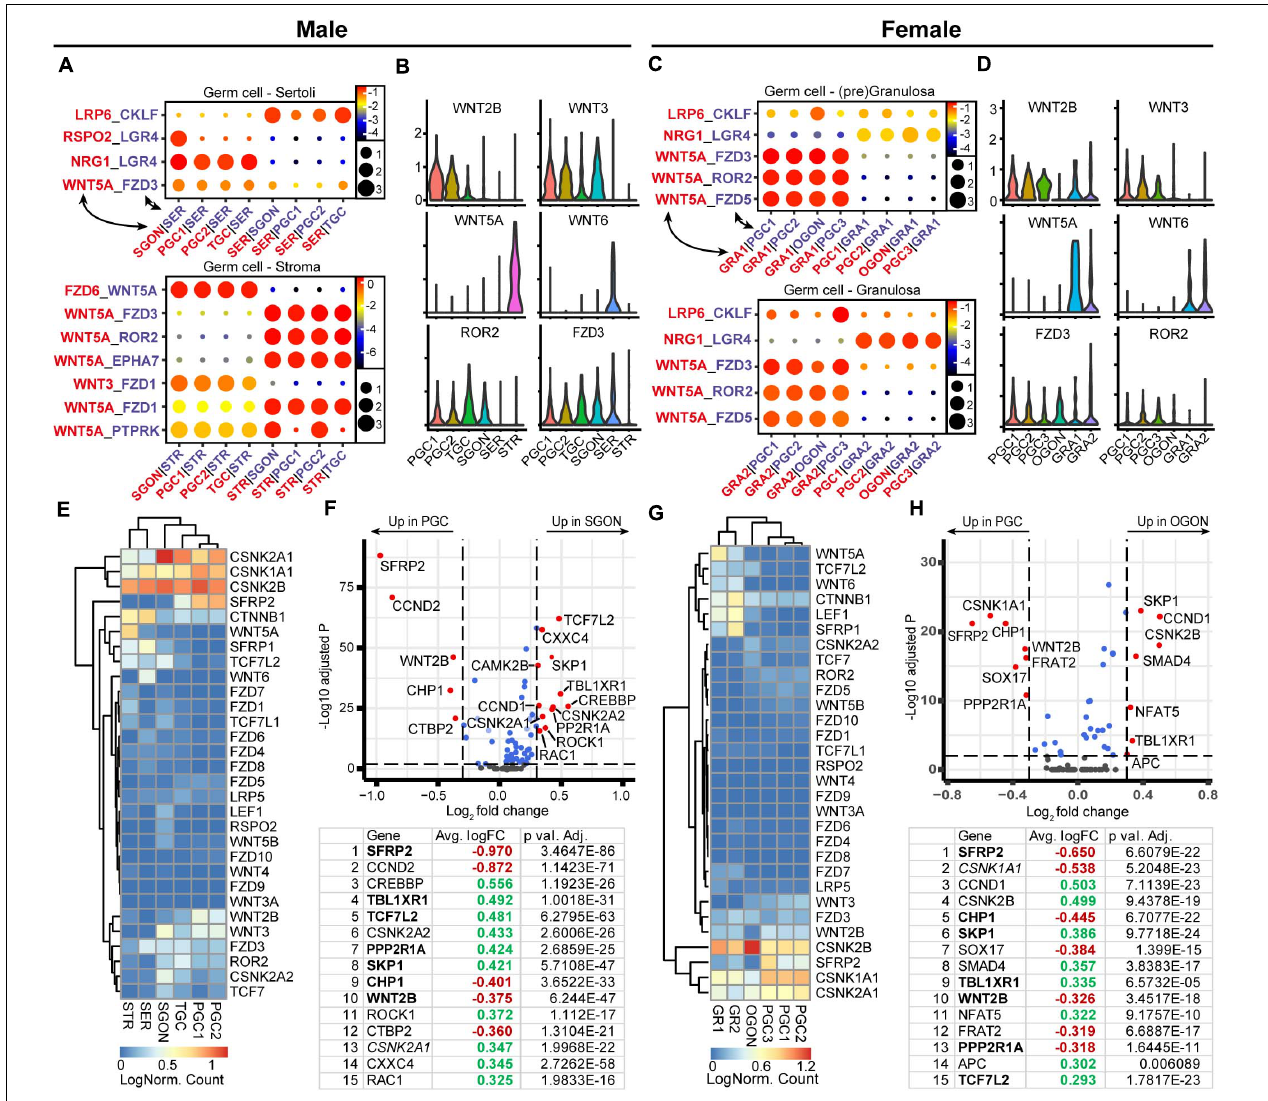
FIGURE 5 | Expression of WNT ligand–receptor pairs and downstream pathway effectors in fetal gonads. (A) CellphoneDB analysis of WNT interactions between different clusters in male fetal gonads. Depicted are − log 10 p -values (circle size) and log 2 means (circle color) for the interacting pairs, for selected pairwise cluster combinations. (B) Violin plots of selected WNT-associated ligands and receptors in male germ and somatic clusters. (C) CellphoneDB analysis of WNT interactions between different clusters in female fetal gonads. (D) Violin plots of selected WNT-associated ligands and receptors in female germ and somatic clusters. (E) Heatmap showing the expression of genes of interest associated with WNT signaling pathway in male germ and somatic cell clusters. (F) A volcano plot showing WNT-related genes between PGC and GON clusters in male gonads. Table shows the top 15 differentially expressed genes. Genes in bold are common between male and female, while genes in italics show divergent regulation. (G) Heatmap showing the expression of genes of interest associated with WNT signaling pathway in female germ and somatic cell clusters. (H) A volcano plot showing WNT-related genes between PGC and GON clusters in female gonads. Table shows the top 15 differentially expressed genes. Genes in bold are common between male and female, while genes in italics show divergent